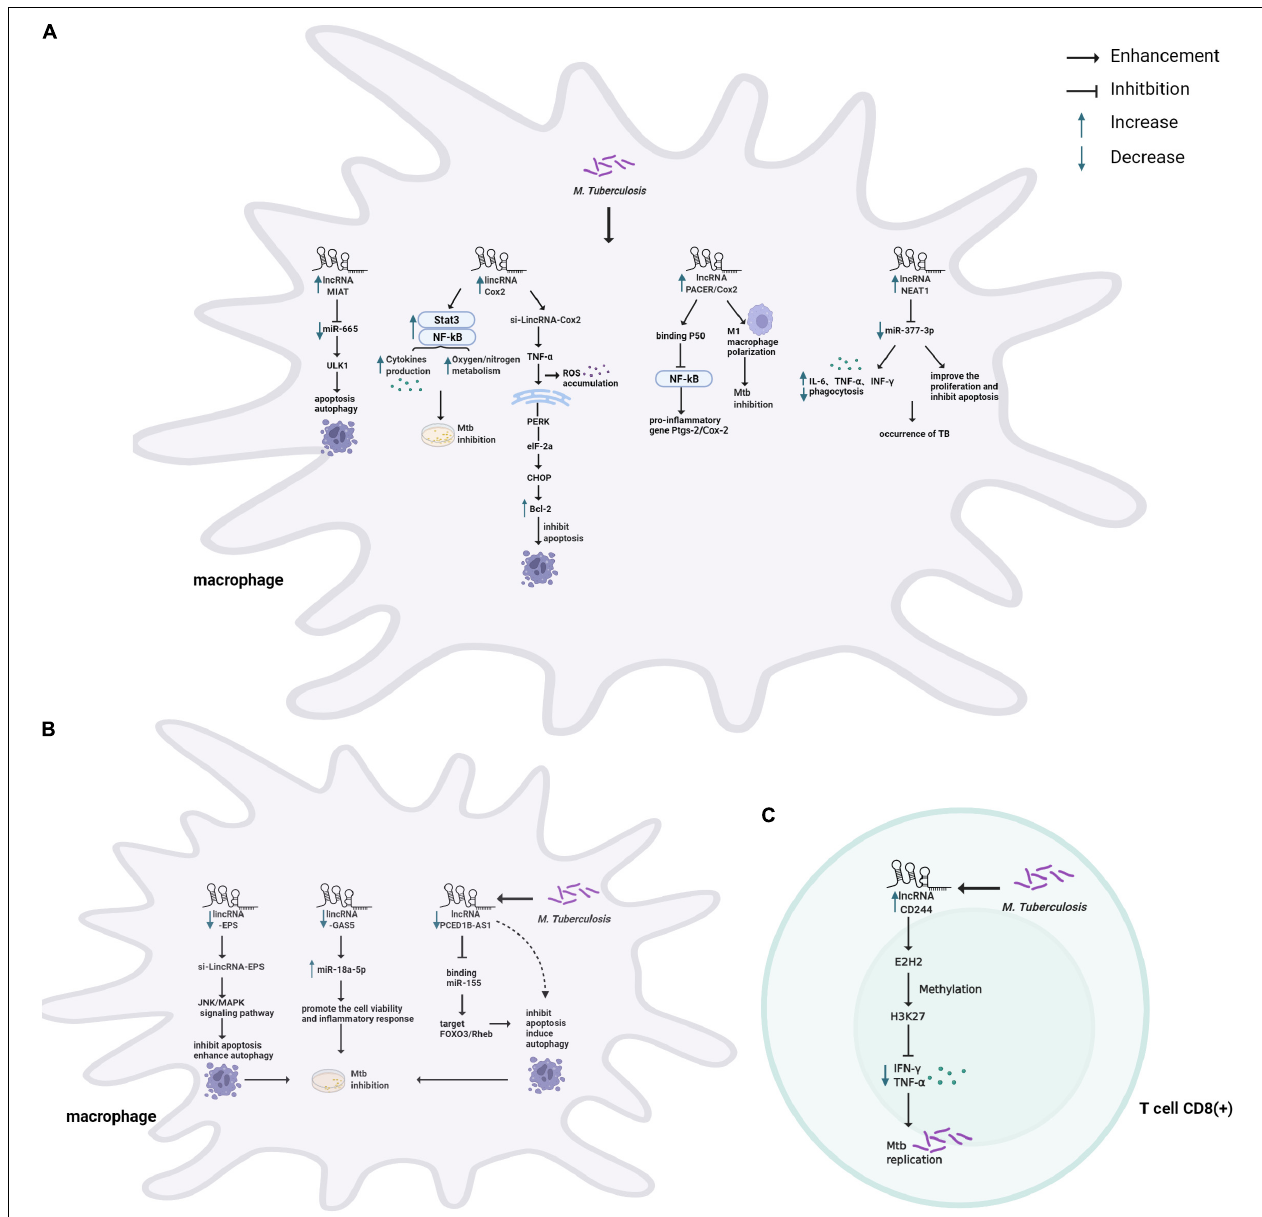
FIGURE 2 | Schematic representation of the role of lncRNAs in host immune system during Mtb infection. (A) TB infection causes upregulation of lncRNAs modulating the immune system of macrophages. lncRNA MIAT modulates apoptosis and autophagy through the miR-665/ULK1 crosstalk. COX-2 modulates inflammatory response by activating NF- κ b/STAT3, associating with p50 (a repressive subunit of NF- κ b), and M1 macrophage polarization, and induces apoptosis by activating the PERK-eIF-2 α -CHOP signaling pathway. NEAT1 modulates inflammatory response and apoptosis through targeting miR-377-3p. (B) TB infection causes downregulation of lncRNAs modulating the immune system of macrophages. LincRNA-EPS inhibited apoptosis and enhanced autophagy by activating the JNK/MAPK signaling pathway. GAS5 promotes the cell vitality and inflammatory response by sponging miR-18a-5p. PCED1B-AS1 can directly bind to miR-155 to inhibit apoptosis and induce autophagy. (C) TB infection causes upregulation of lncRNA-CD244 to interact with EZH2 and mediates H3K27 trimethylation at ifng/tnfa loci, thereby suppressing IFN- γ /TNF- α expression and increasing bacterial proliferation in T